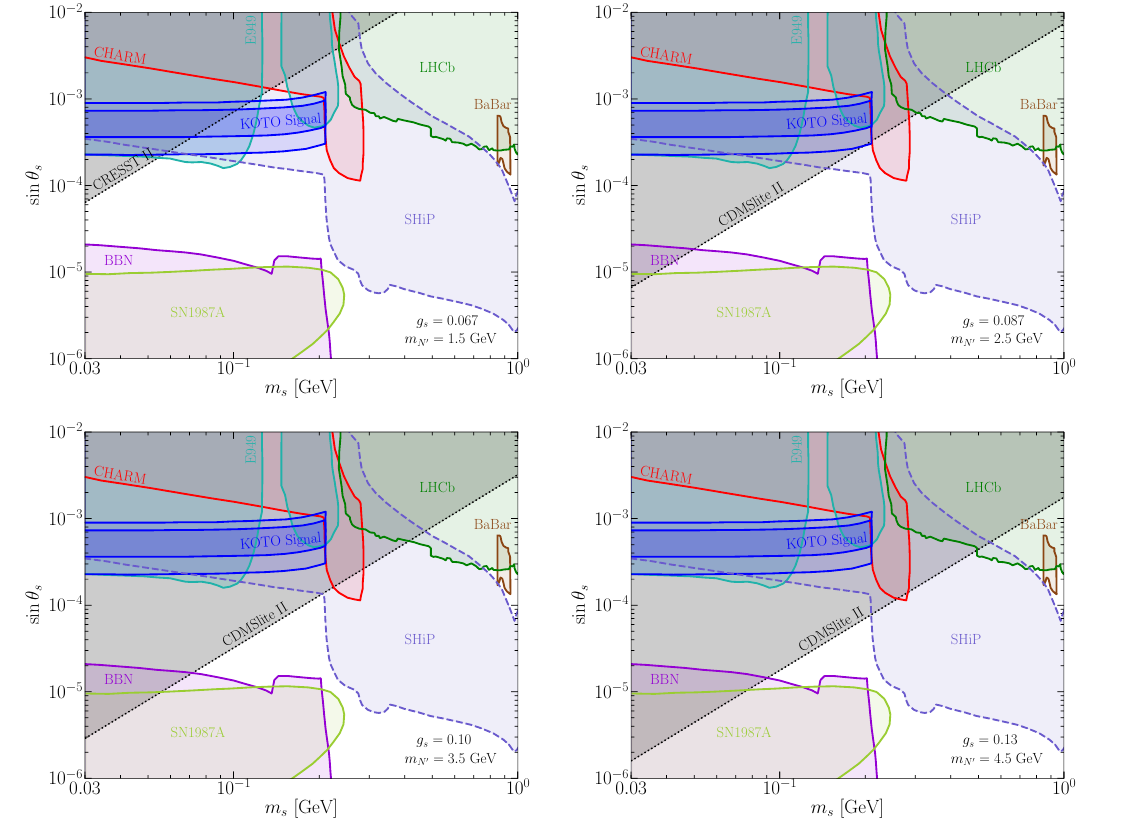
Figure 6 . Constraints on a light singlet mediator, in the m The four plots consider di(cid:11)erent values of the DM mass m the direct detection constraints (black dotted line) di(cid:11)er; all other constraints are the same. The dark blue regions are favored at 1 (cid:27) and 2 (cid:27) for the KOTO anomaly. The red, cyan, green and brown regions are excluded by CHARM [64], E949 [65], LHCb [66] and BaBar experiments [67], respectively. The violet and light-green regions are excluded by BBN [68] and supernova data [69]. Sensitivity projection for the SHiP experiment is indicated by the dashed blue-gray boundary. The experimental bounds, along with the projected sensitivity, are taken from ref.